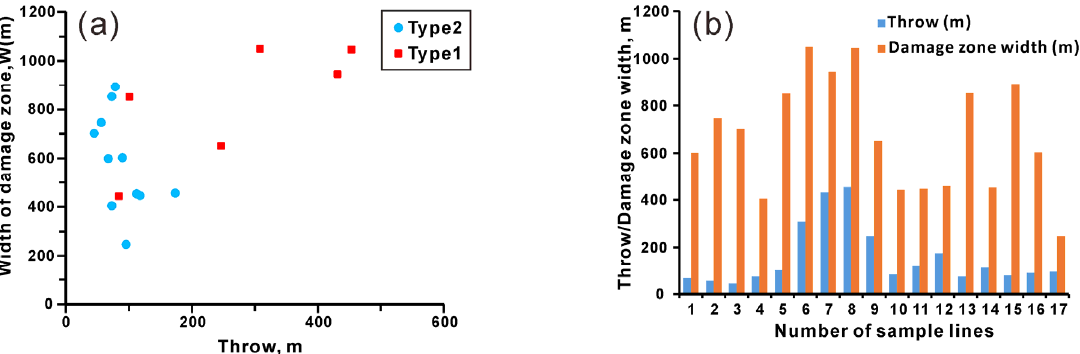
Figure 9. ( a ) The damage zone width versus Throw, ( b ) Width of damage zones and its corresponding throw of the top of the Yijianfang formation (surface T 74 ) along the strike of the Shunbei 5 fault zone.